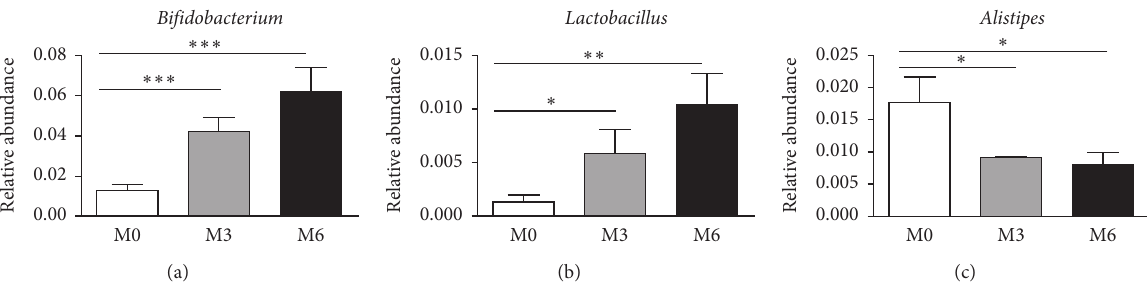
Figure 4: The relative abundance of bacterial taxa at the genus level before and after before and after inulin supplement. (a) Bifidobacterium ; (b) Lactobacillus ; (c) Alistipes M0, baseline; M3, at three months after inulin intervention; M6, at six months after inulin